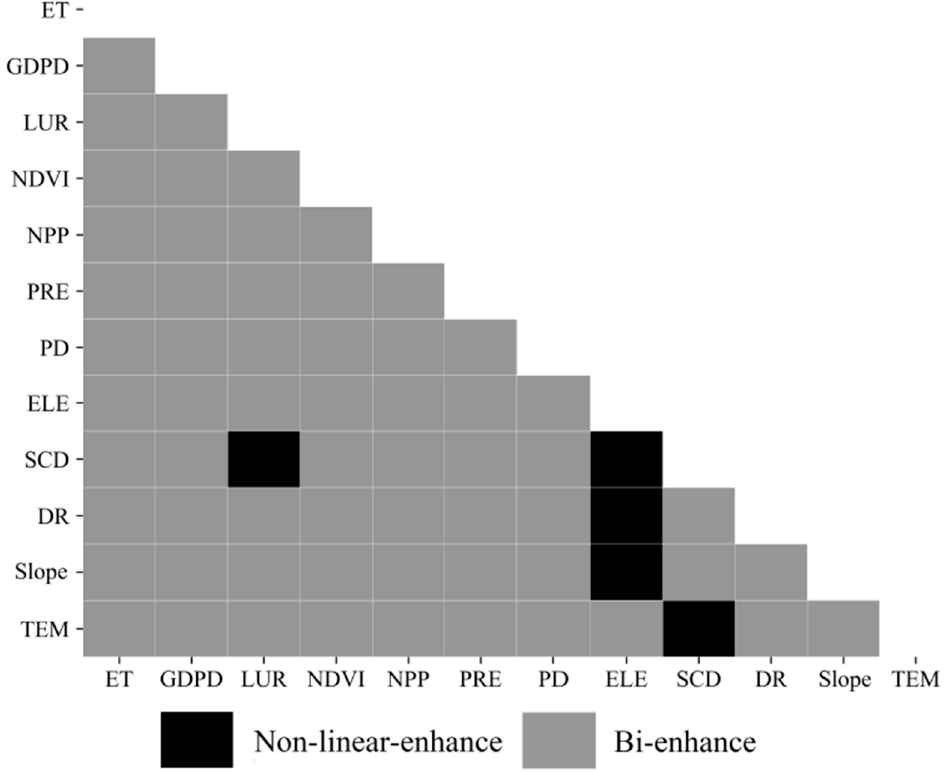
Figure 10. Interaction type between pairs of forces influencing EVI.